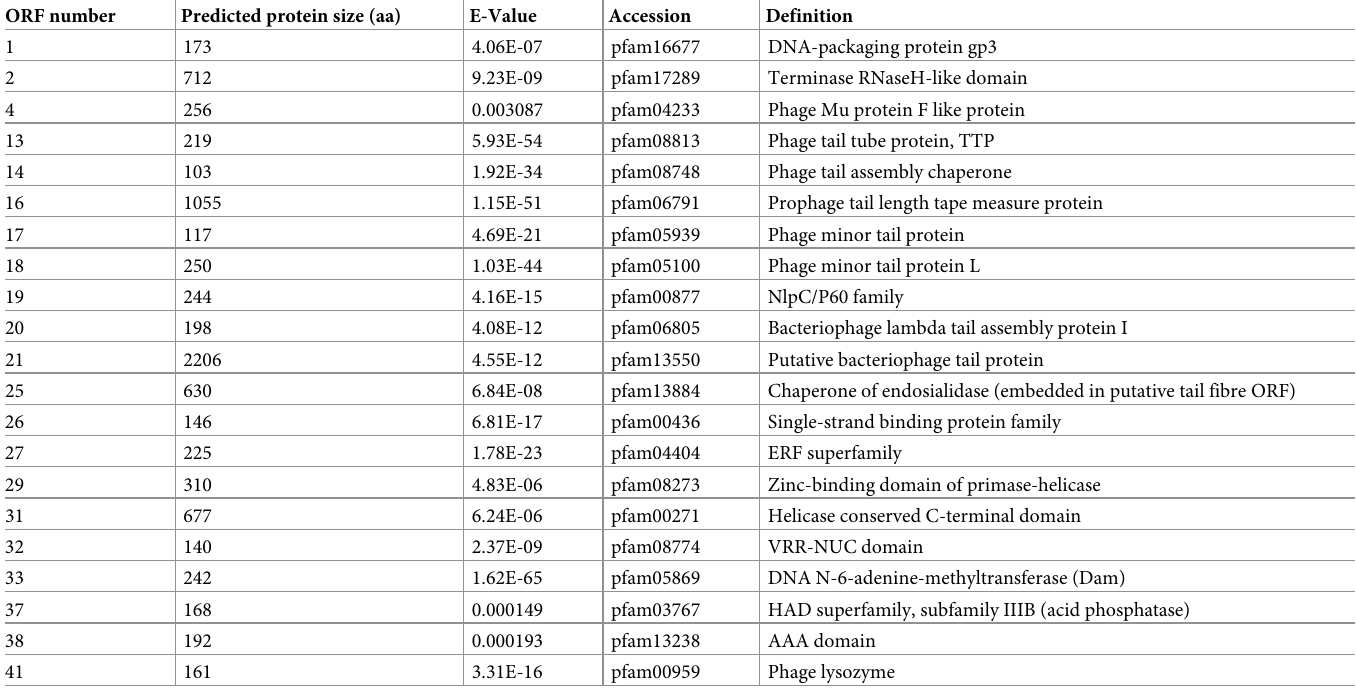
Table 4. KMI8 ORFs where predicted protein function is known. Predicted function based on Pfam database of conserved functional domains.